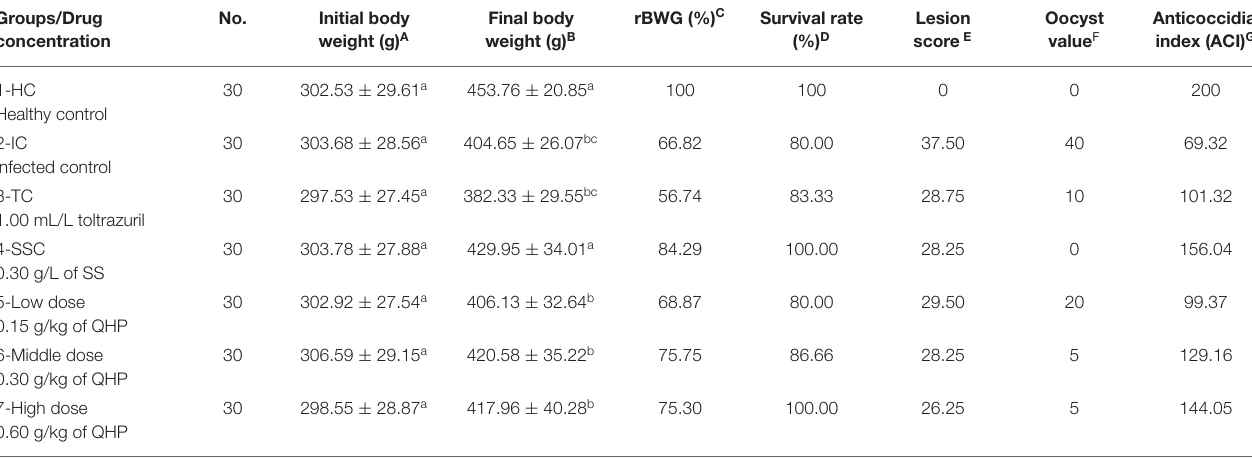
TABLE 2 | Effects of Qinghao Powder on the rBWG, lesion score, and ACI in chicks against Eimeria tenella ( n = 30). Groups/Drug No. Initial body concentration weight (g) A